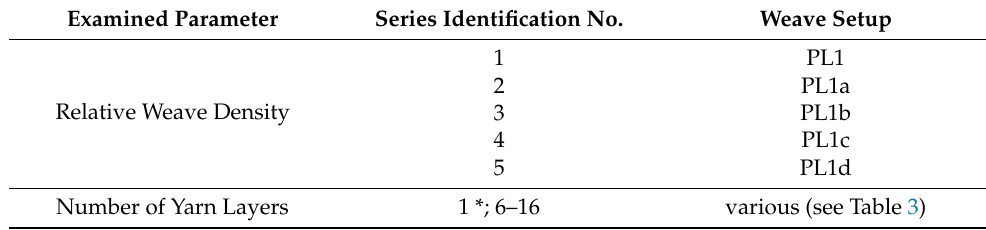
Table 2. Test series numbering and